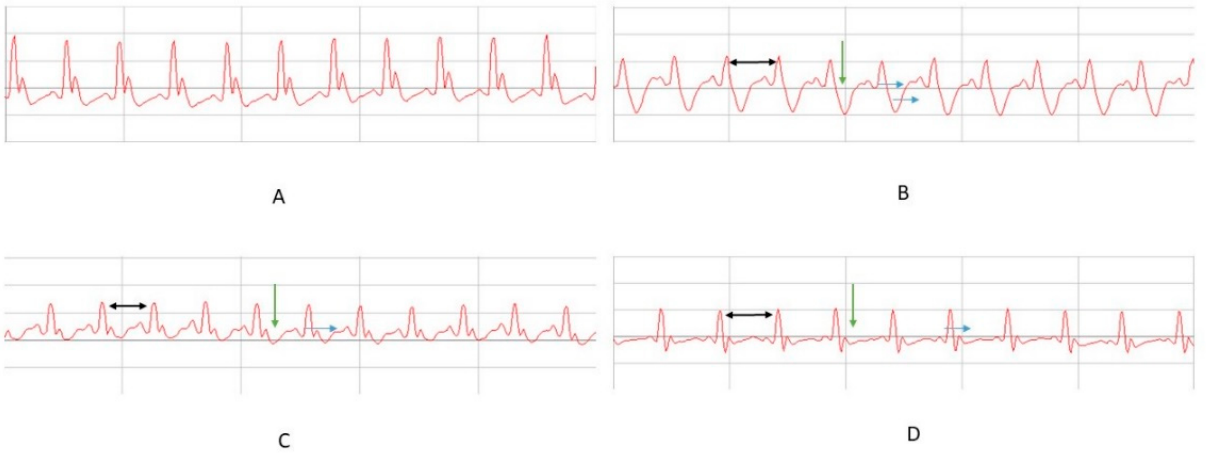
Figure 4. The ECG records in experimental groups with ( A ) C group, ( B ) C-ISO group, ( C ) NSO + ISO group, and ( D ) GSO + ISO on day 15 after MI induction 24 h after ISO administration (groups 2 to 4): increased RR interval (black arrow), ST-segment depression (green arrow), QT interval prolongation (blue arrow). The amplitude of these changes was different in the experimental groups.